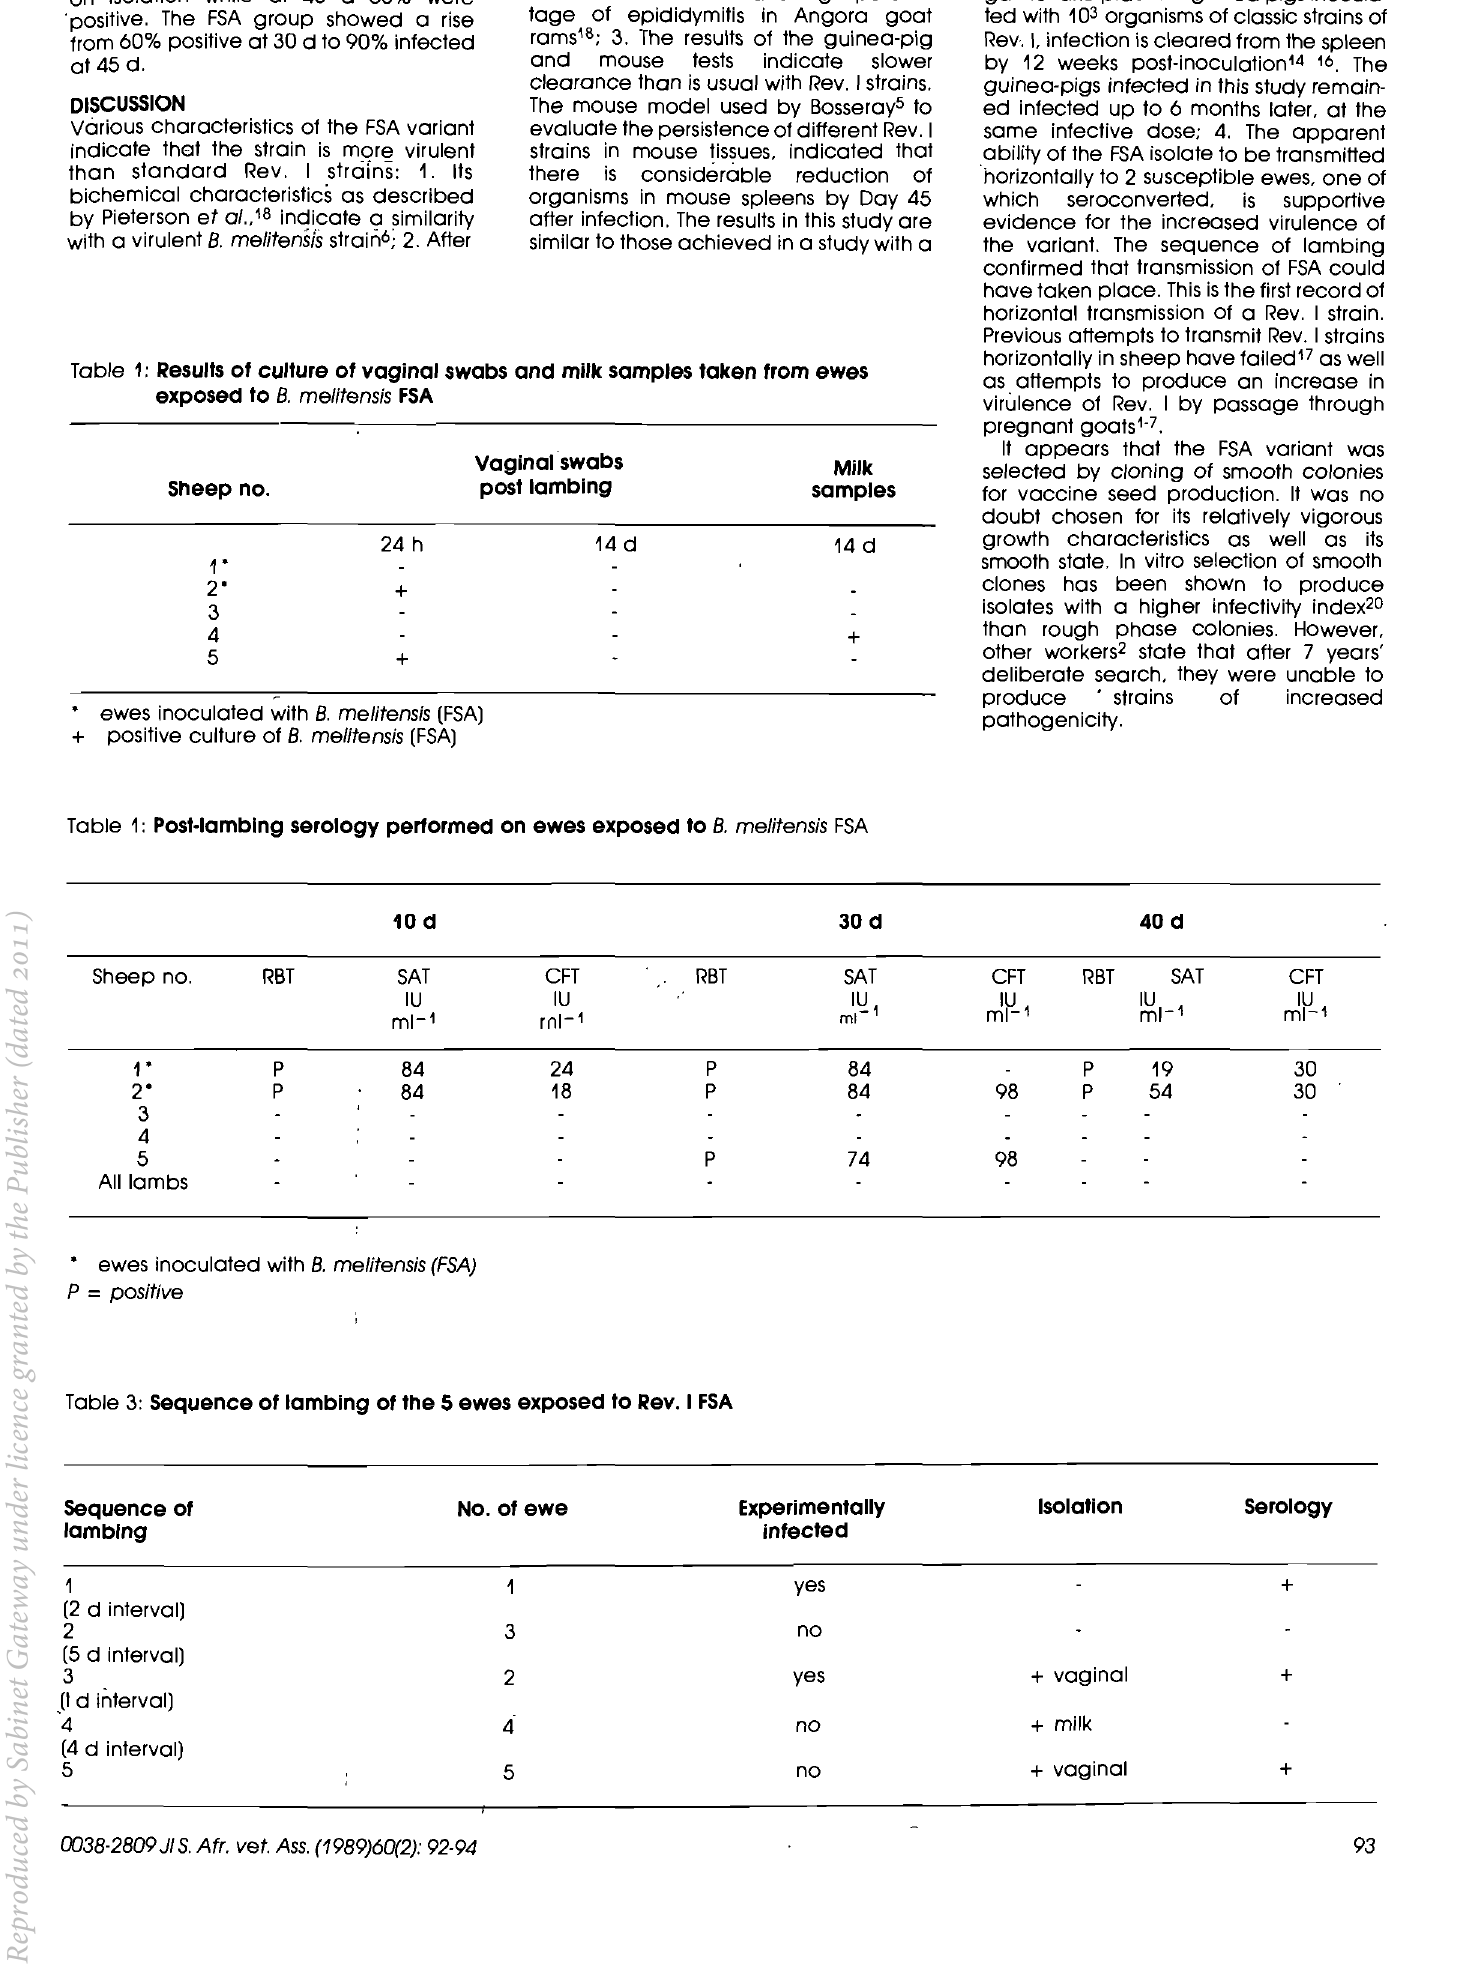
Sequence of No. of ewe